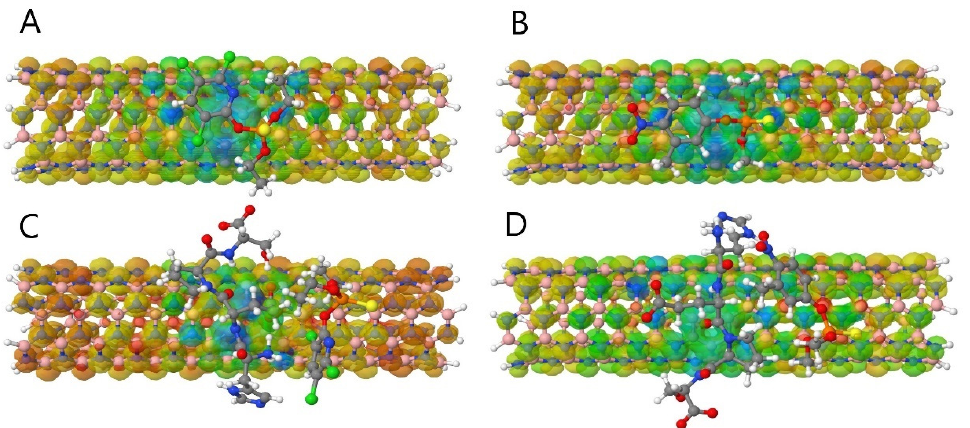
Figure 4. Frontier molecular orbital electrophilic susceptibility of pesticides (chlorpyrifos (chl) and fenitrothion (fen)) adsorbed on carbon-doped armchair (5,5) boron nitride nanotube (BN55-CC1) without ( A , B ) and decorated with tetrapeptide (4pep) ( C , D ).